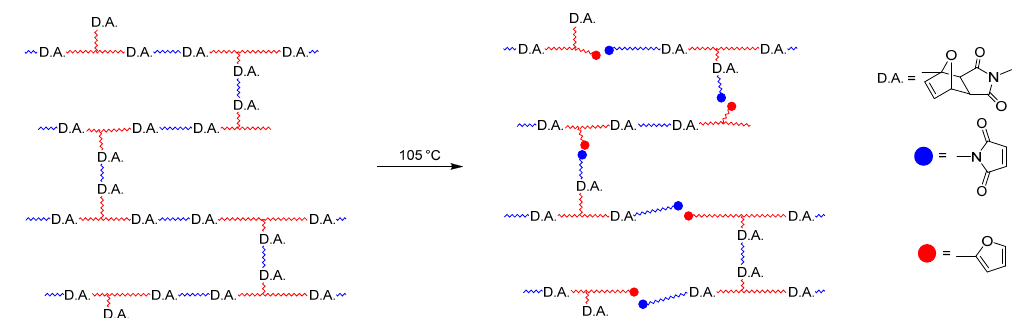
Figure 5. Partial opening of Diels–Alder adducts under the recycling conditions.